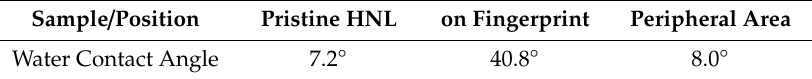
Table 1. Water contact angle on fingerprint-attached